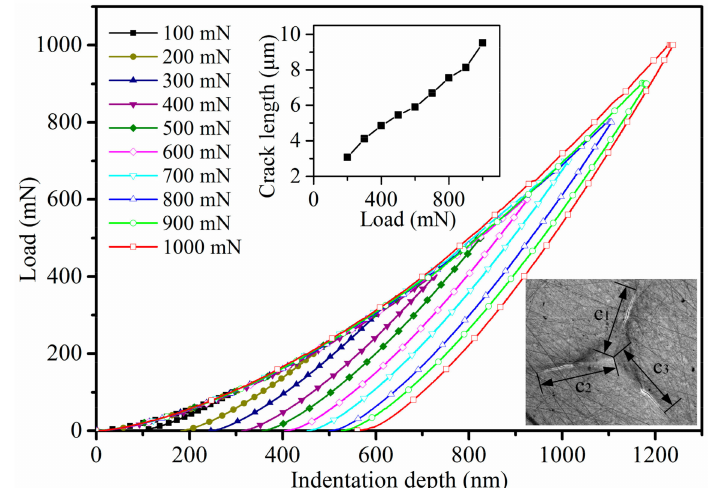
Figure 7. Load versus indentation depth curves with a maximum load range from 100–1000 mN for 4H-SiC single crystal samples (the small chart shows the crack length-load curve and the measuring method of the crack length is shown in the lower right